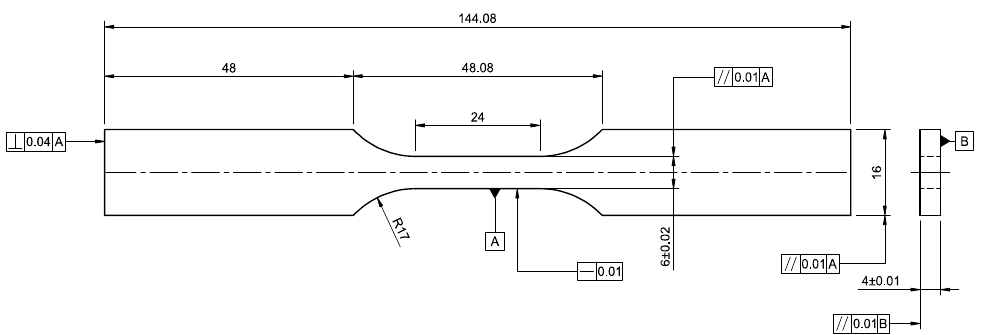
Figure 3. Fatigue specimen design according to the standard [20], units: mm.